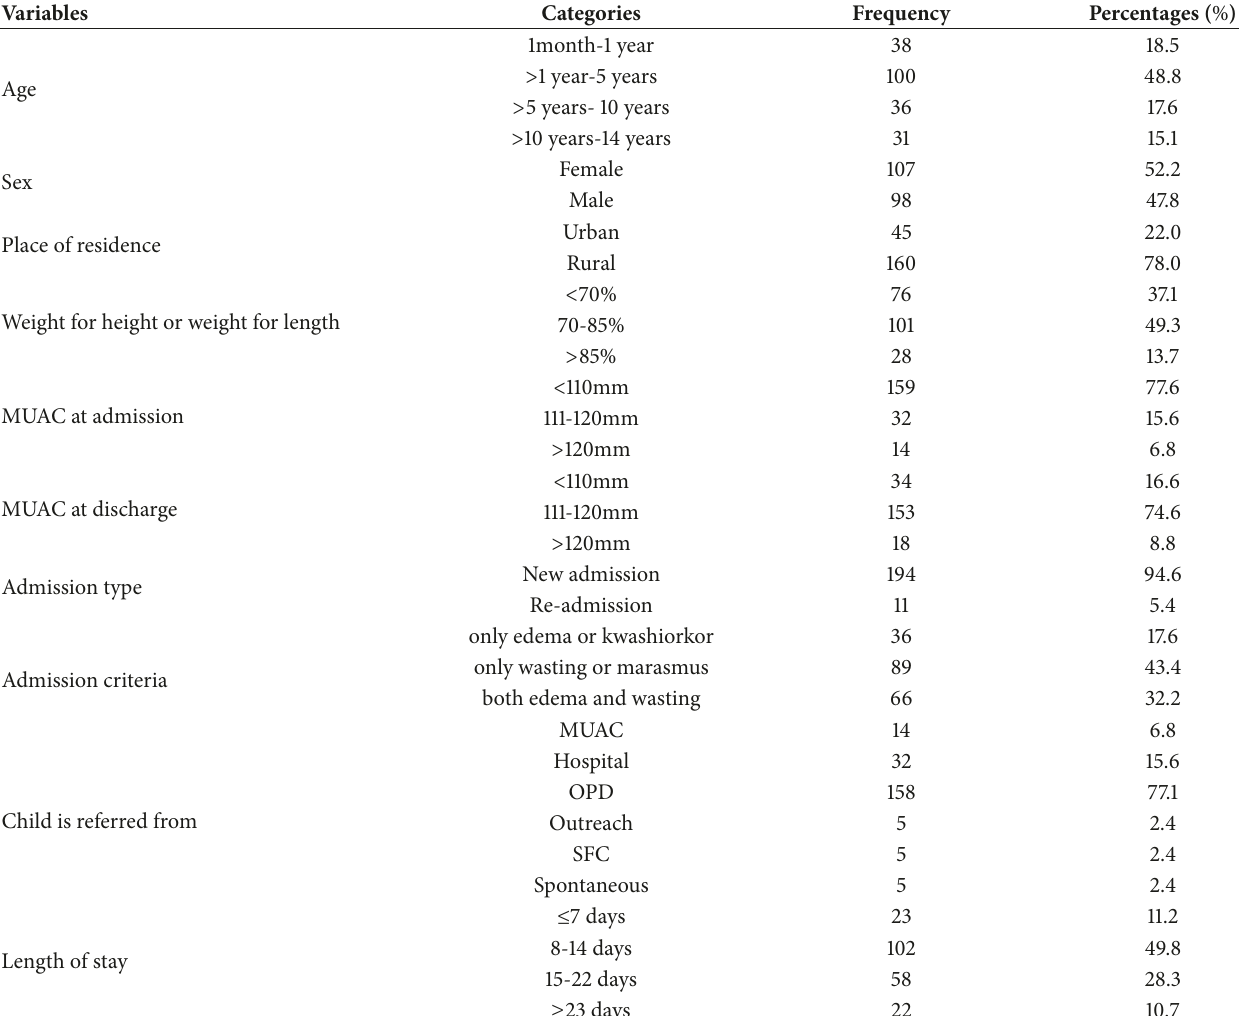
Table 1: Distribution of demographic and admission information on treatment outcome of children with SAM admitted to NRH, West Ethiopia from November 2015 to April 2017